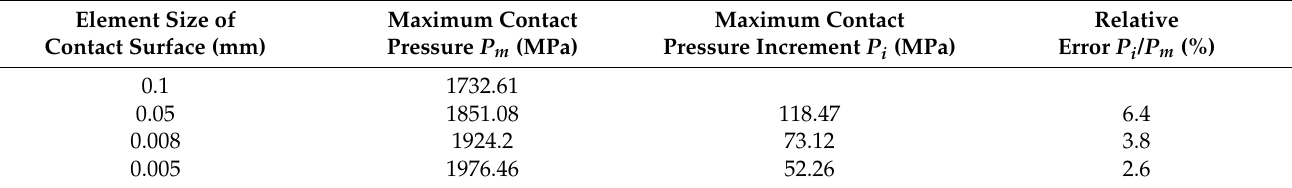
Table 6. Relative error for the finite element method.